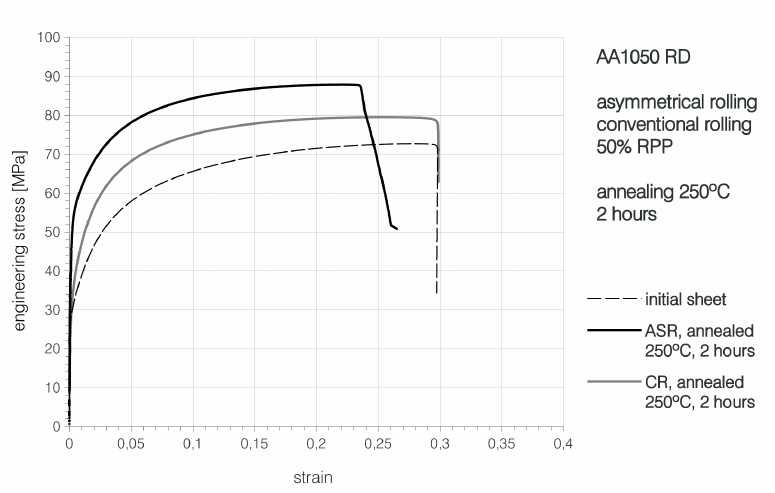
Figure 8. RD tensile tests of rolled (50%RPP) and annealed (250 ◦ C for 2 h) specimens. Comparison between ASR and CR (adapted from [25] with permissions from authors,